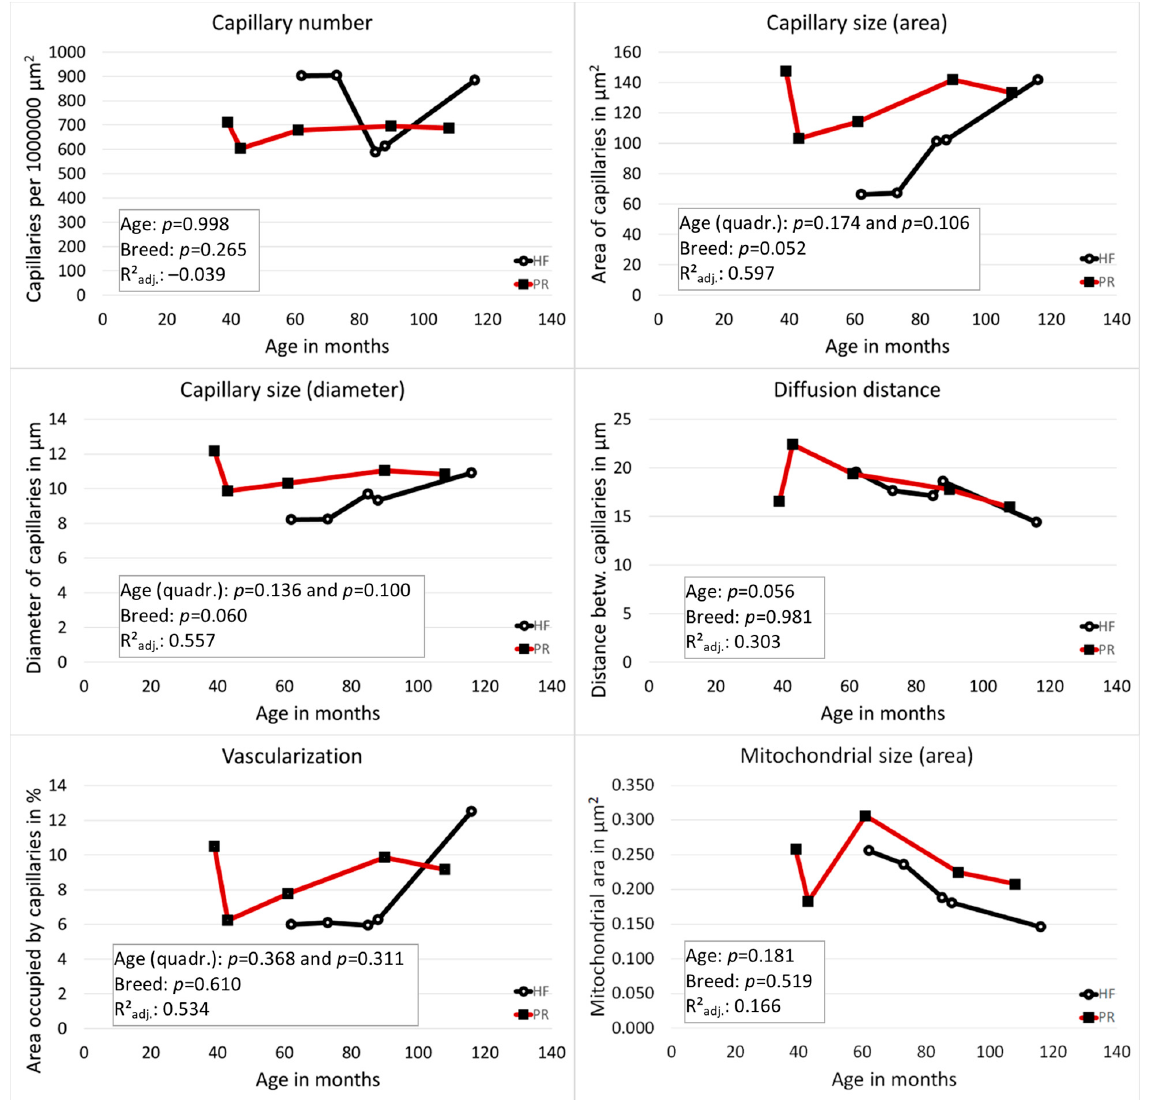
Figure 2. Vascular and mitochondrial parameters measured in the ovarian zona parenchymatosa without visible functional structures. HF (black lines) Holstein-Friesian. PR (red lines) Polish Red cow. Inserted boxes show statistical results from the multivariable general linear model, which was used to analyze the influence of age and breed. Table 2. Capillary and mitochondria properties in bovine ovarian tissue samples and telomere length and percentile